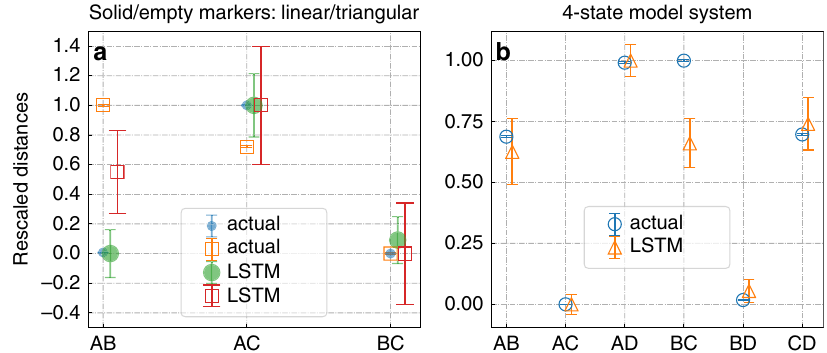
Fig. 7 Analysis of embedding layers for model systems. Our analysis of the embedding layer constructed for a the linear and triangular 3-state and b the 4-state model systems. In a , we use solid circle and empty square markers, respectively to represent linear and triangular 3-state model potentials. In each plot, the data points are shifted slightly to the right for clarity. The distances marked actual and LSTM represent rescaled mean transition times as per Eqs. (22) and (21), respectively. Error bars were calculated as standard errors over 50 different ð x (cid:2) x 0 Þ 2 simulation of Langevin dynamics 44 with these model potentials are shown in where W = 0.0001 and G ð x ; x 0 Þ ¼ e (cid:2) 2 σ 2 denotes a Gaussian function centered at Fig. 2a – c. x 0 with width σ = 0.8. We also build a 4-state model system with governing interaction potential: Molecular dynamics details . The integration timestep for the Langevin dynamics simulation was 0.01 units, and the simulation was performed at β = The different local minima corresponding to the model potentials in Eq. (23) and Eq. (24) are illustrated in Fig. 2. We call these as linear 3-state, triangular 3-state, and 4-state models, respectively. The free energy surfaces generated from the thermostat 48 .